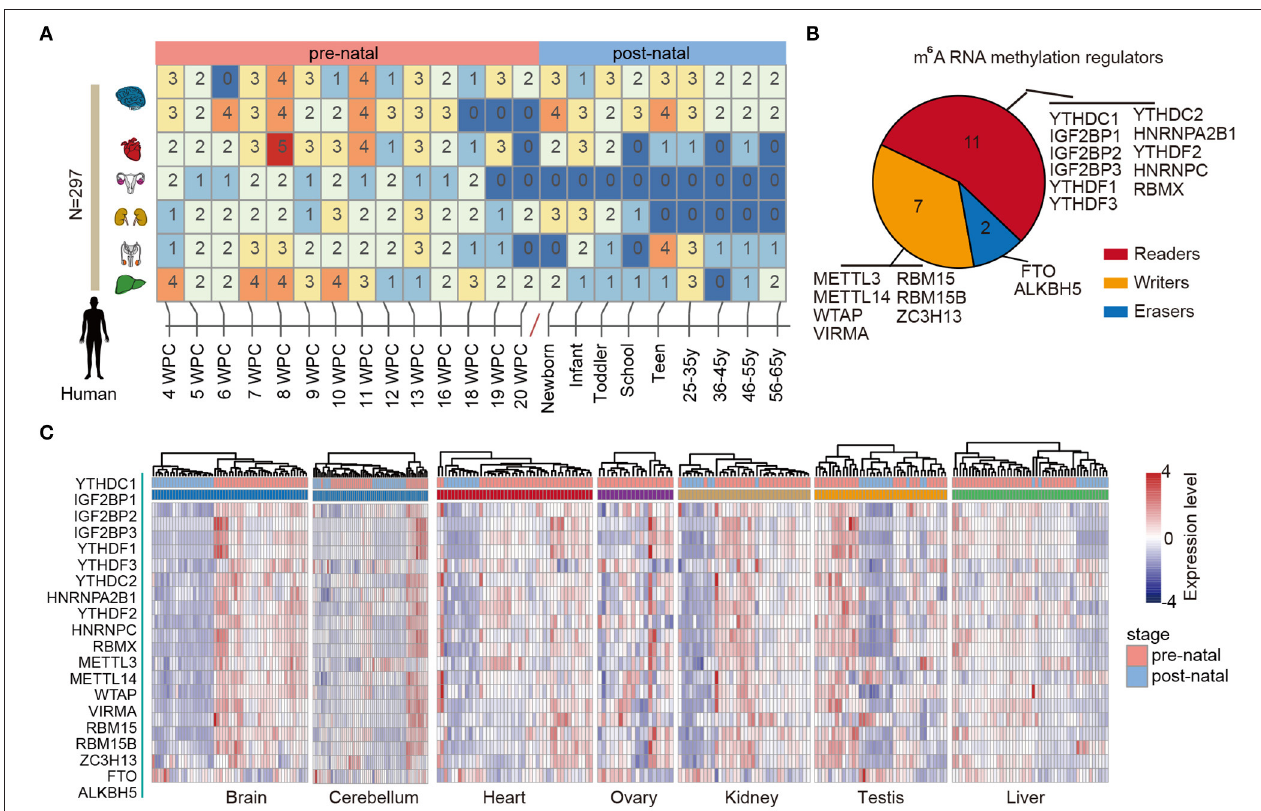
FIGURE 1 | Dynamic expression of m 6 A regulators during tissue development. (A) Heat map showing the number of samples in different development stages of multiple tissues. (B) Pie chart for the number of m 6 A regulators, including 11 readers, 7 writers, and 2 erasers. (C) Heat maps showing the expression of m 6 A regulators in different tissues. The prenatal and postnatal samples were indicated with red and blue